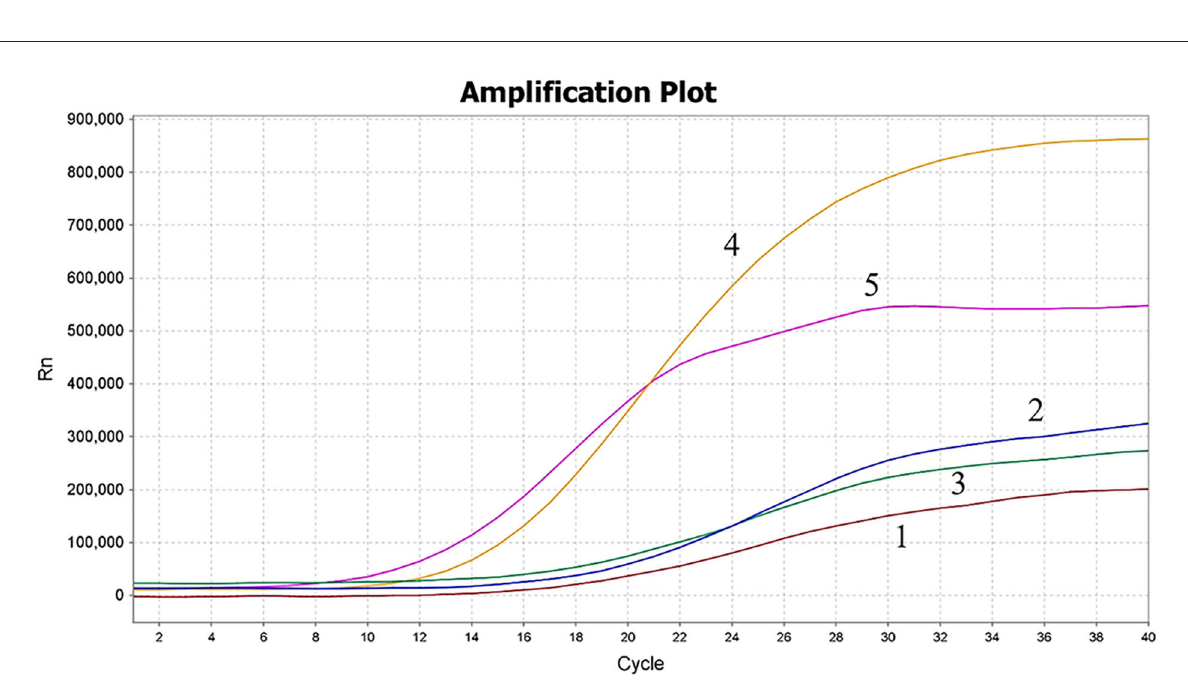
results from the corresponding real-time PCR assay.